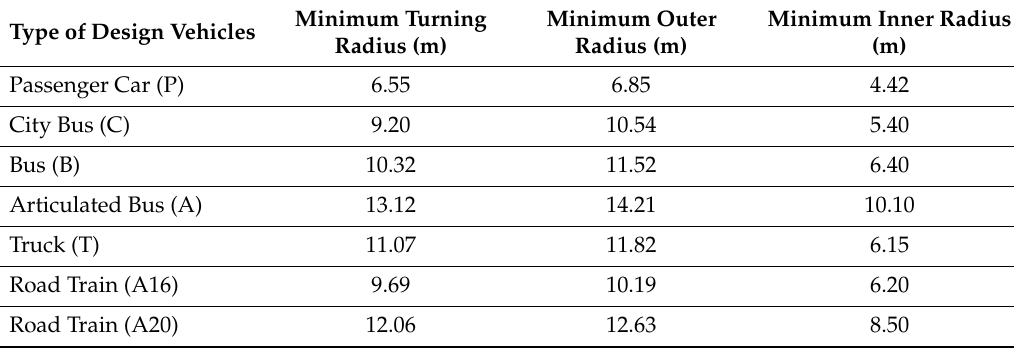
Table 2. Minimum turning radius of design vehicles (see Figure 11).